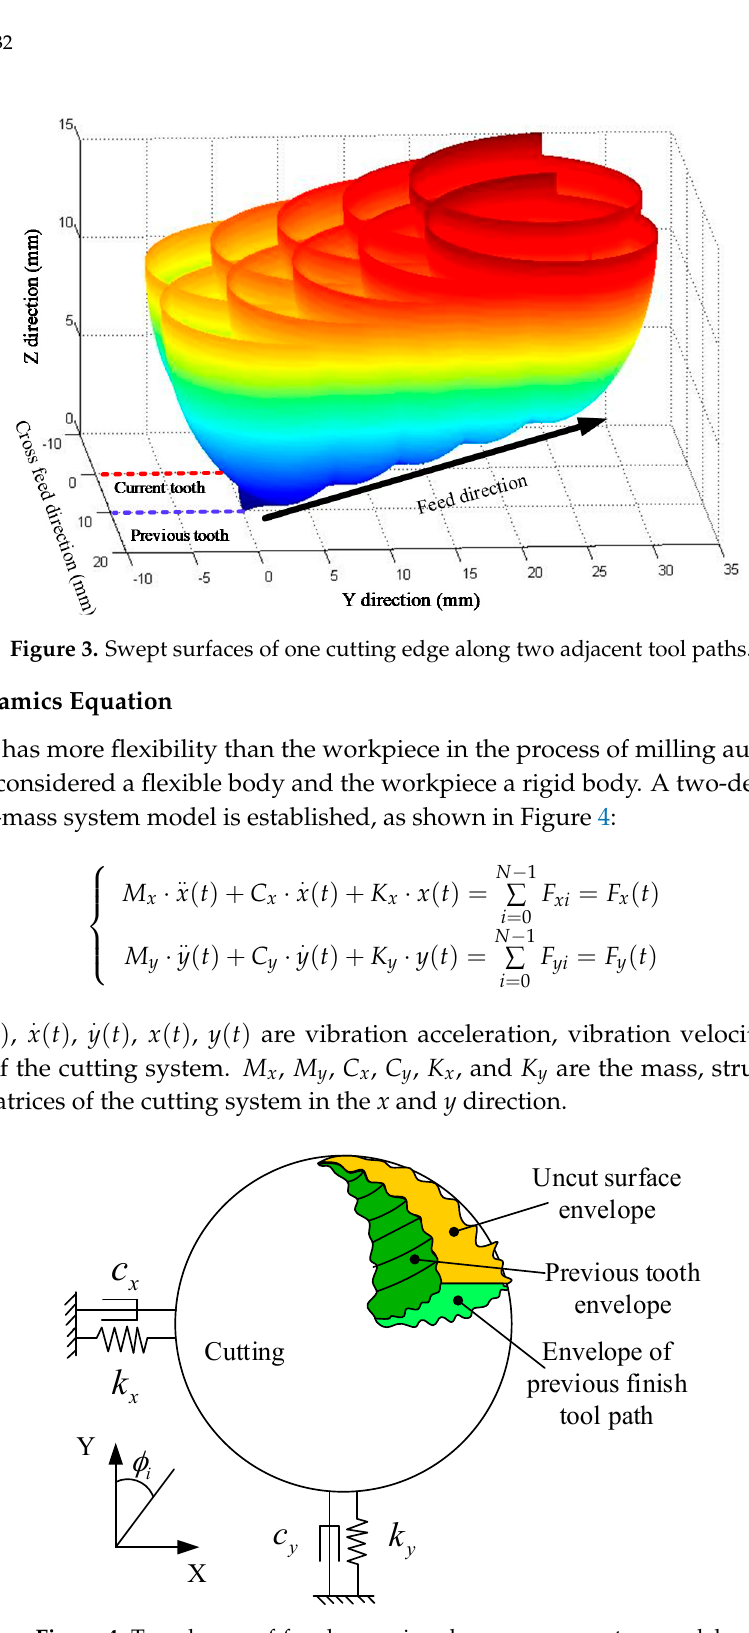
Figure 4. Two-degree-of-freedom spring-damper-mass system model.